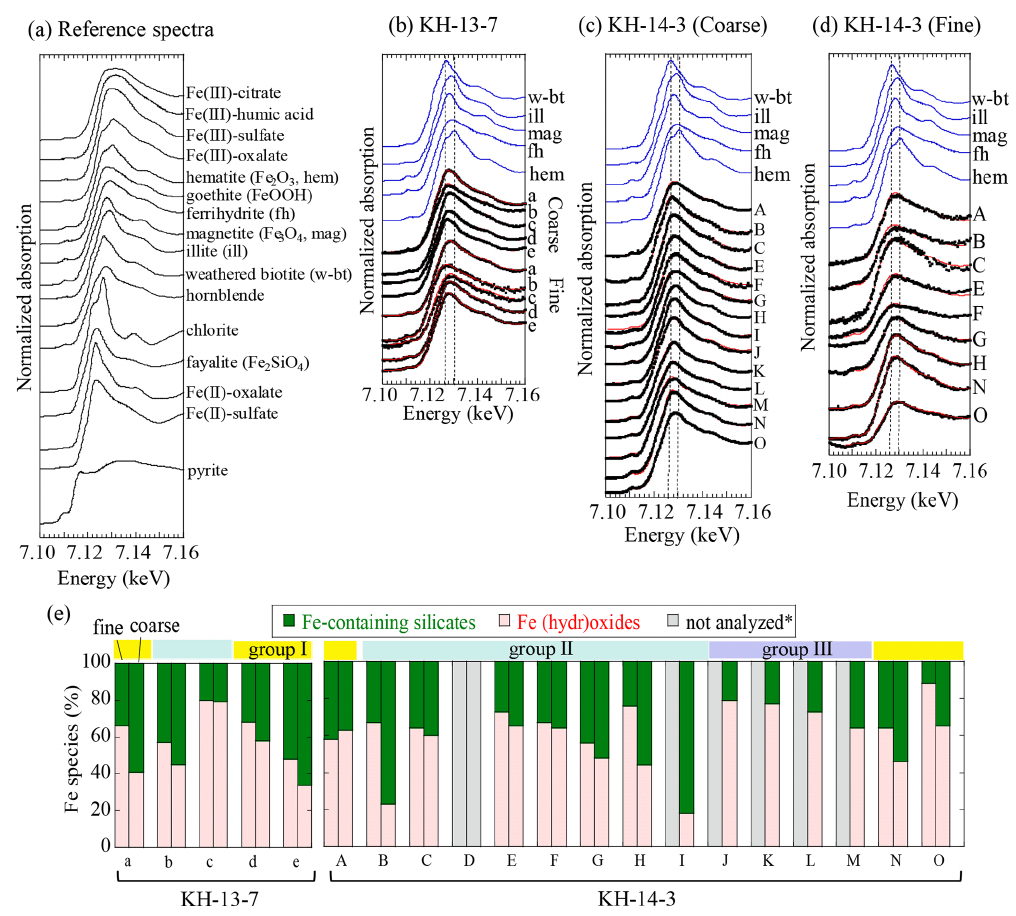
Figure 5. Iron K-edge XANES spectra of (a) reference species, (b) KH-13-7 samples, (c) coarse particles of KH-14-3 samples, and (d) fine particles of KH-14-3 samples. (e) Fraction of each Fe species in the fine and coarse samples. Colored bars above the graph (d) indicate the different air mass groups. ∗ Not analyzed due to insufficient Fe. Yellow, blue, and purple areas indicate groups I (air masses from the direction of East Asia), II (air masses from the central and eastern Pacific), and III (air masses from the northern North Pacific),